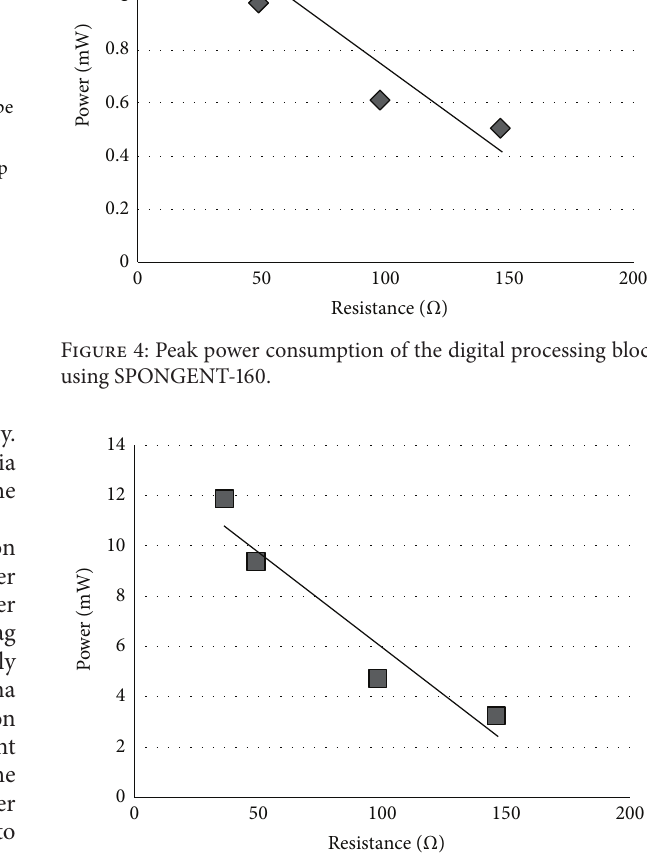
Figure 5: Peak power consumption of the digital processing block using